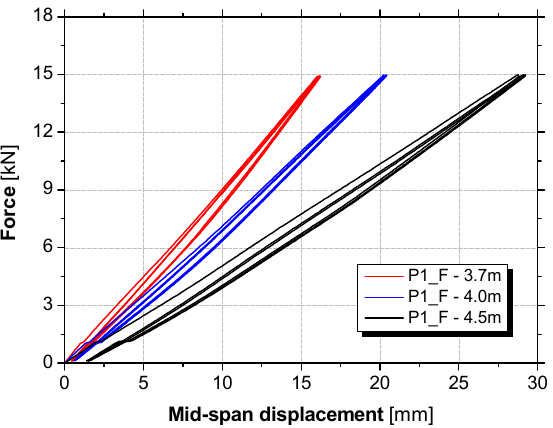
Figure 9. Force versus midspan displacement of the flexural tests with variable span (panel P1_F). According to Timoshenko beam theory, the midspan deflection ( δ ) of a simply sup- ported beam in a three-point bending configuration can be computed using Equation (1), where F is the applied load and L is the span